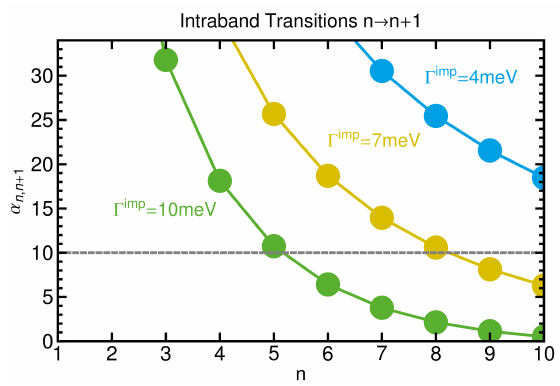
Figure 13: Importance of acoustic phonons. Minimal value of α n , n +1 defined in Eq. (68) is shown for the transition LL n → LL n +1 as a function of n . Three different values ( 4 meV, 7 meV and 10 meV) are used for the impurity-induced Landau level broadening. Assuming that α n , n +1 ≈ 10 fulfills the condition in Eq. (68) , acoustic phonons are only important for transitions involving Landau levels higher than n = 5 , cf. the dashed horizontal line.